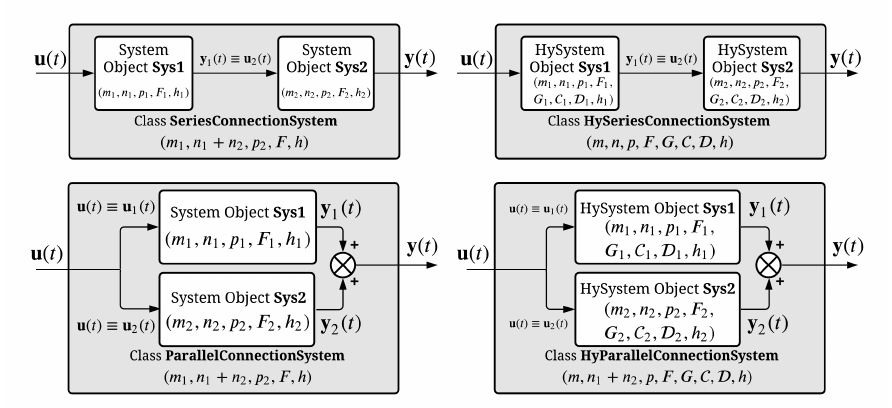
Figure 2. Series and parallel interconnections for general-purpose and hybrid